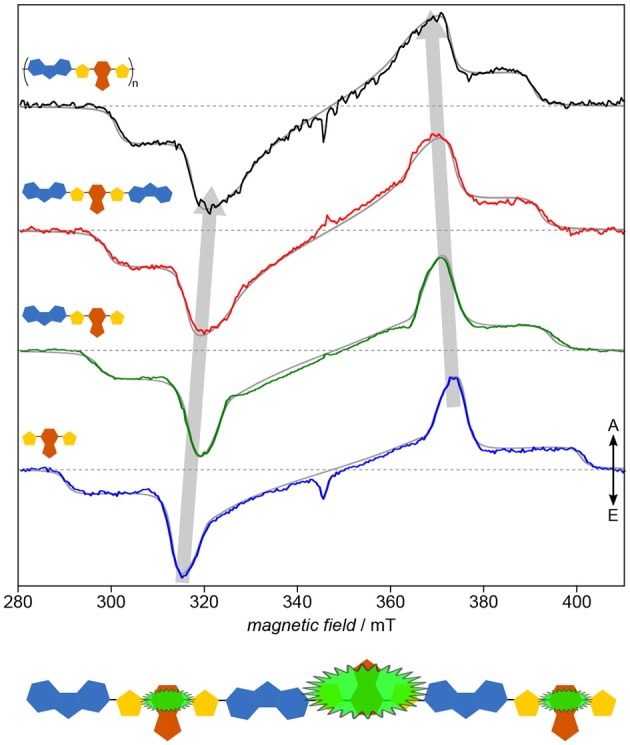
Electronic structure: Identifying the dominating building block. On first sight, all that seems to change when going from the TBT moiety to the polymer PCDTBT is the width of the spectra, being a measure of the exciton delocalization. Both, detailed quantum-chemical investigations as well as spectral simulations of the TREPR spectra (gray solid lines) support this notion. Hence, the TBT unit, in itself a push-pull system, seems to entirely dominate the electronic structure even of the polymer. All TREPR spectra have been recorded at 80 K and X-band frequencies (about 9.7 GHz). For details see Matt et al. (2018b).